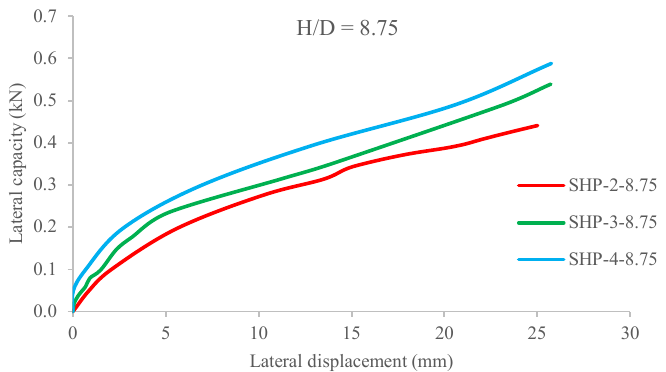
Figure 12. Load–displacement curve for Lateral loading—Experimental.